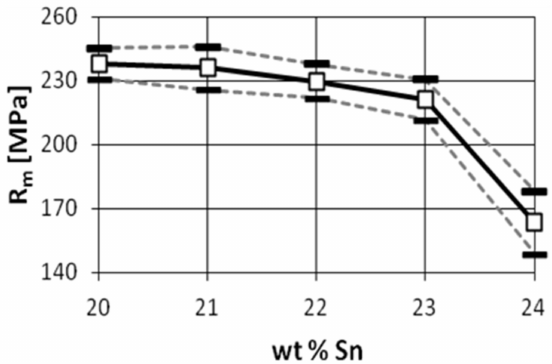
Figure 5. Tensile strength of high-tin bronzes versus tin content [8].